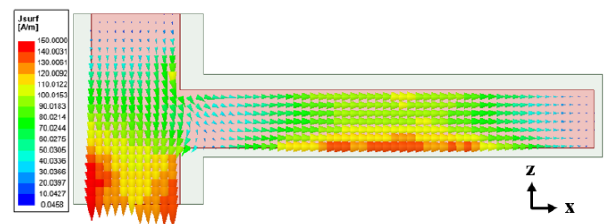
Figure 11. Resonator of the T-type metal.